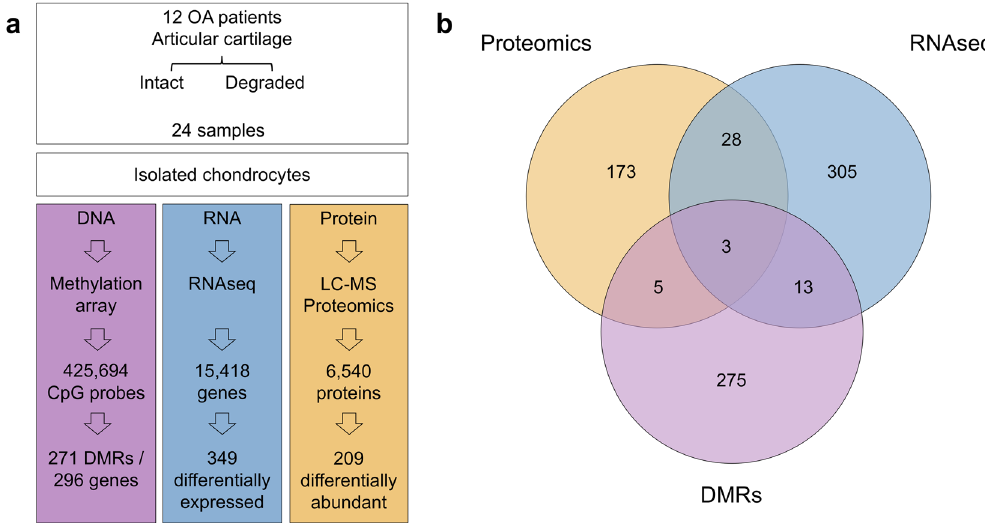
Figure 1. Overview of the genes identified in each –omics experiment and their overlap. ( a ) Schematic view of the 3 functional genomics experiments identifying the number of genes shortlisted for each. ( b ) Venn diagram identifying the number of overlapping shortlisted genes from each individual